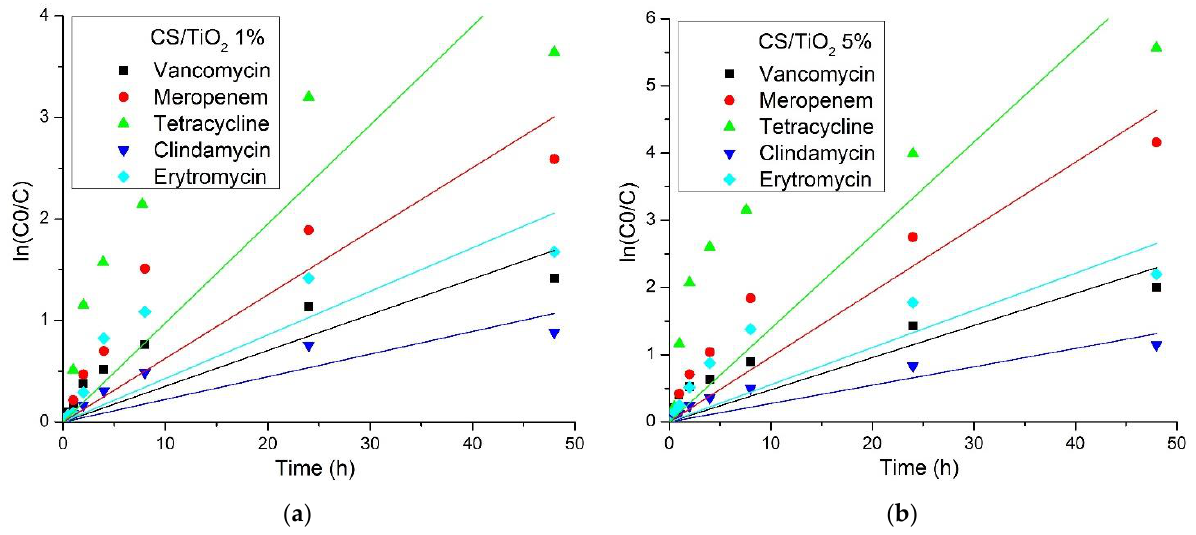
Figure 14. The plots of ln(C 0 /C) vs. irradiation time (t) for ( a ) CS/TiO 2 1% and ( b ) CS/TiO 2 5% membranes.